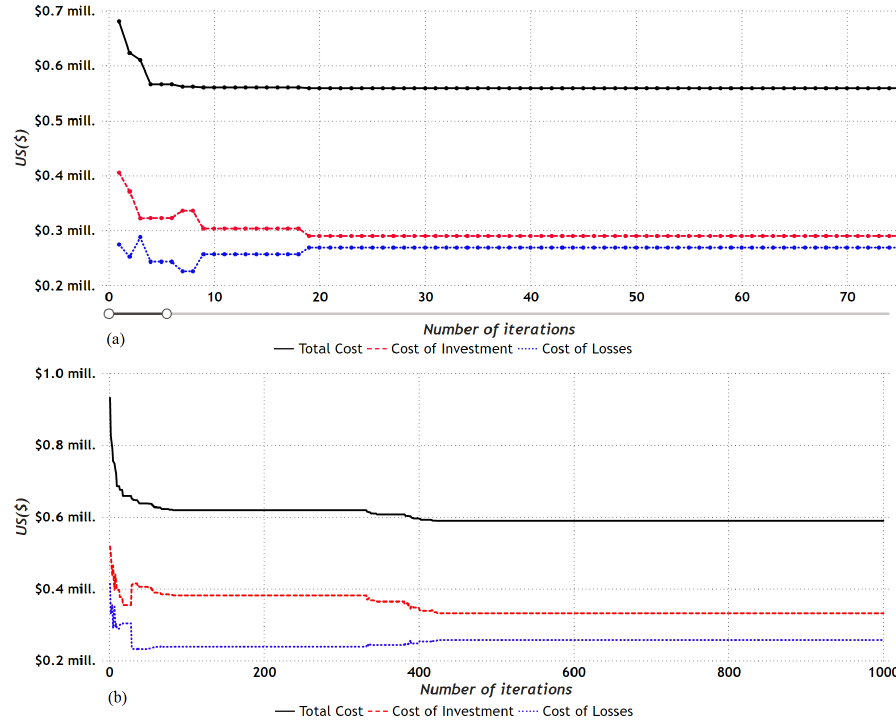
Figure 19. Behavior of the value of the objective function for: ( a ) 8-bus system with unbalanced load; ( b ) 27-bus system with unbalanced